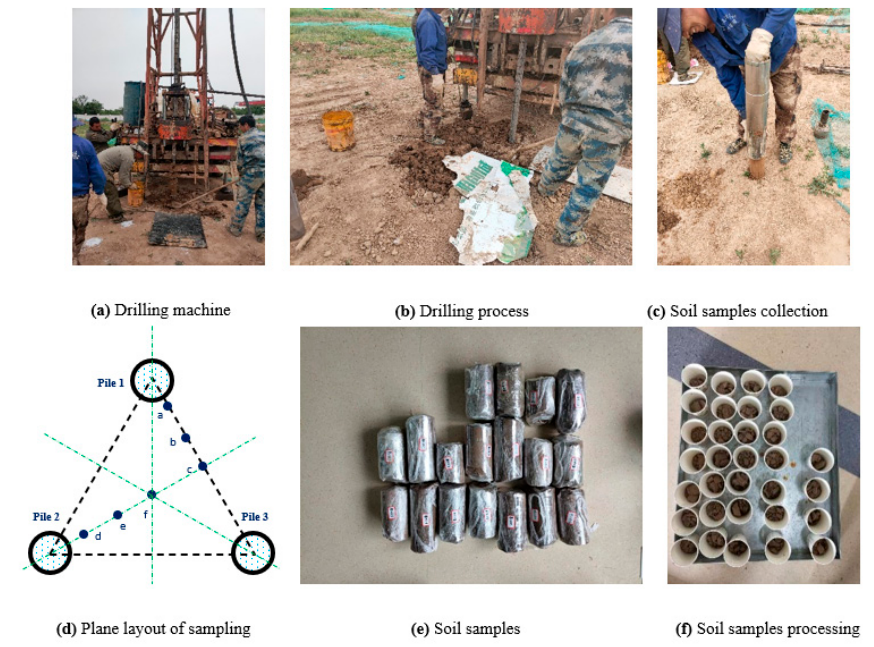
Figure 4. Compaction coefficient tests of soil among the SP − PSC pile